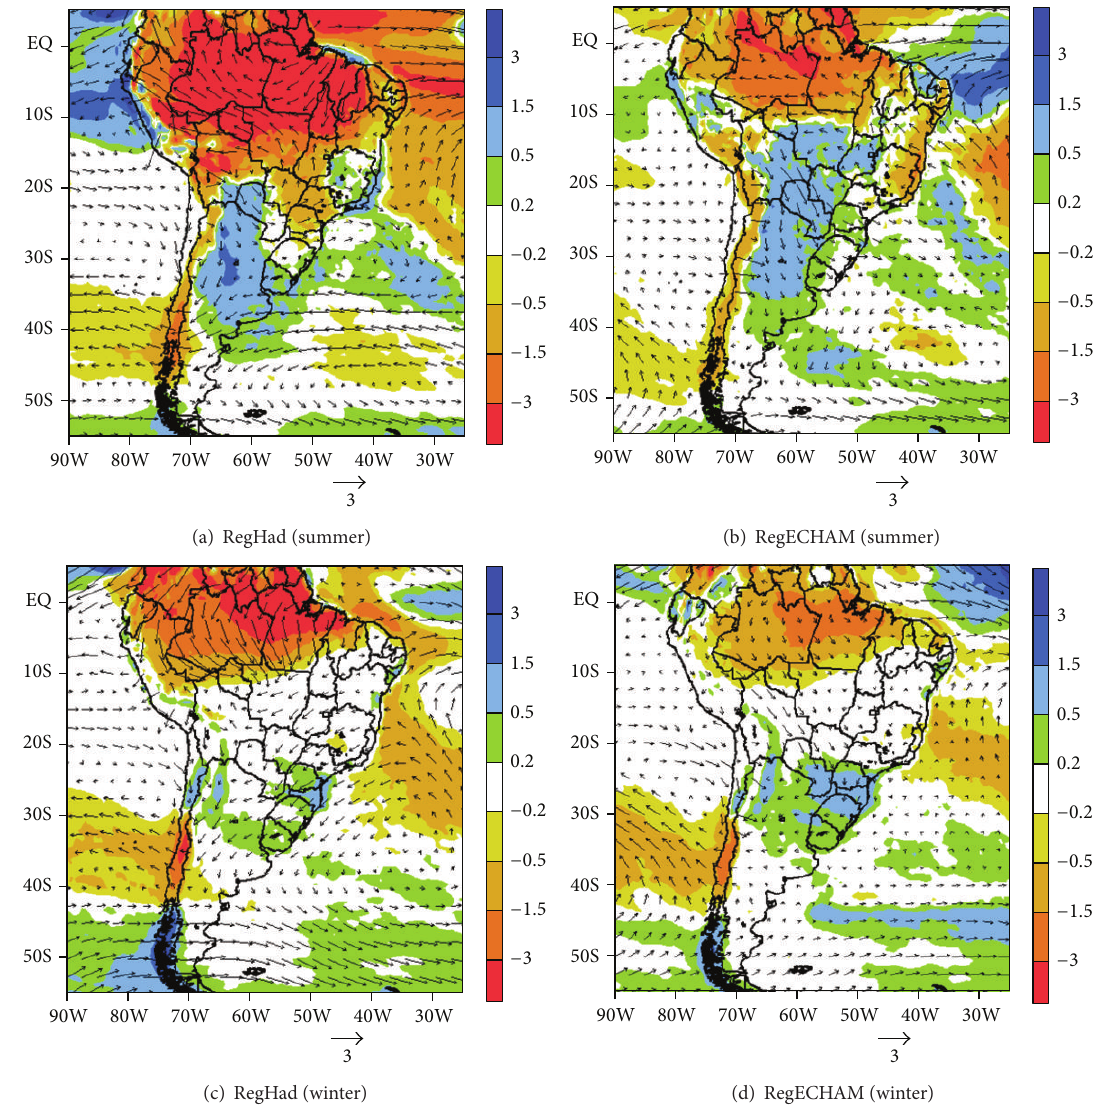
Figure 8: Similar to Figure 6, but in the far-future period (2070–2100 minus 1960–1990). Table 1: Lifecycle of the South American monsoon in the present (1960–1990) climate (details are in the text). Mean